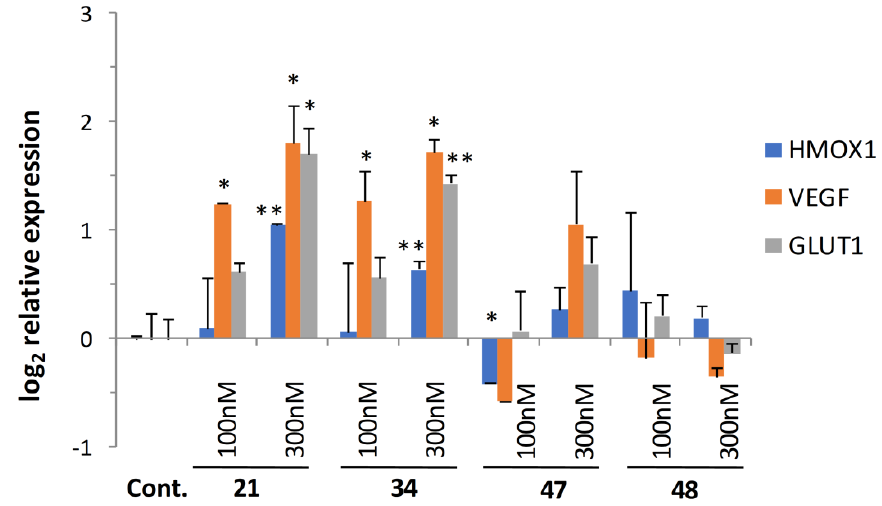
Figure 5. Induction of hypoxia-related gene and glucose transporter expression. HIF1A-regulated genes were activated following treatment with selected analogs in a dose- and cytoprotective activity-dependent manner. Statistical significance ( t -test): * p < 0.05 and ** p < 0.01.